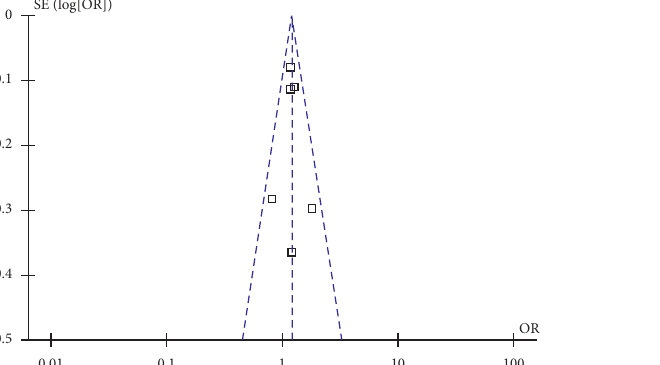
Figure 5: Funnel plots for the publication bias underlying meta-analysis of the association between skipping breakfast and hypertension in the adult